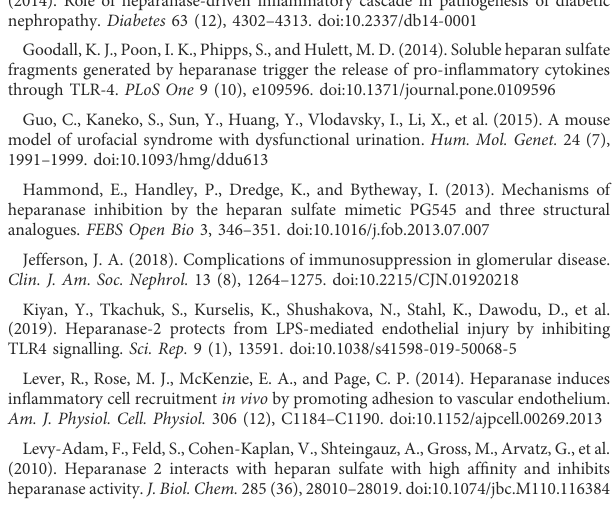
cortical HPSE2 mRNA expression of wild-type mice treated with or without adriamycin for 10 or 23 days. n ≥ 5 (B) . Renal cortical HPSE2 protein expression of wild-type mice treated with or without adriamycin for 10 or 23 days. n ≥ 5 *p < 0.05, **p < 0.01. HPSE2, heparanase-2; AU, arbitrary units; Adria,